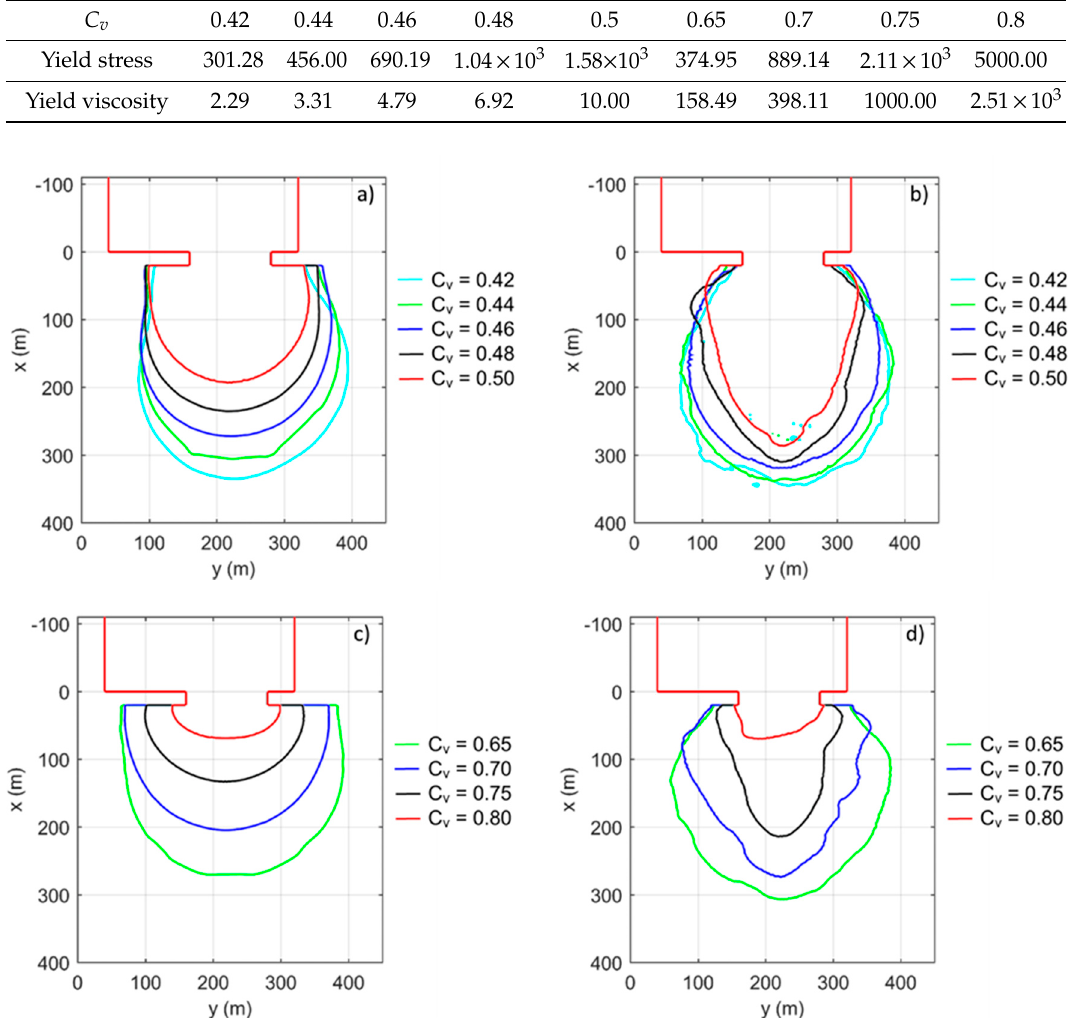
Figure 16. The stoppage boundary profiles for sensitivity analysis of concentration C v . ( a ) Kaolinite simulated by BM; ( b ) kaolinite simulated by MBM; ( c ) typical soils simulated by BM; ( d ) typical soils simulated by MBM.